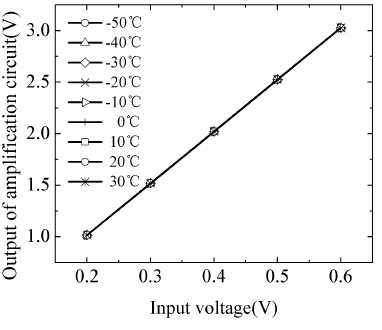
Figure 8. Temperature dependence of the amplification circuit.